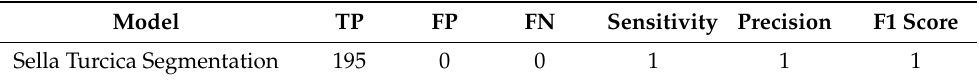
test data. Model TP FP FN Sensitivity Precision F1 Score Sella Turcica Segmentation 195 0 0 1